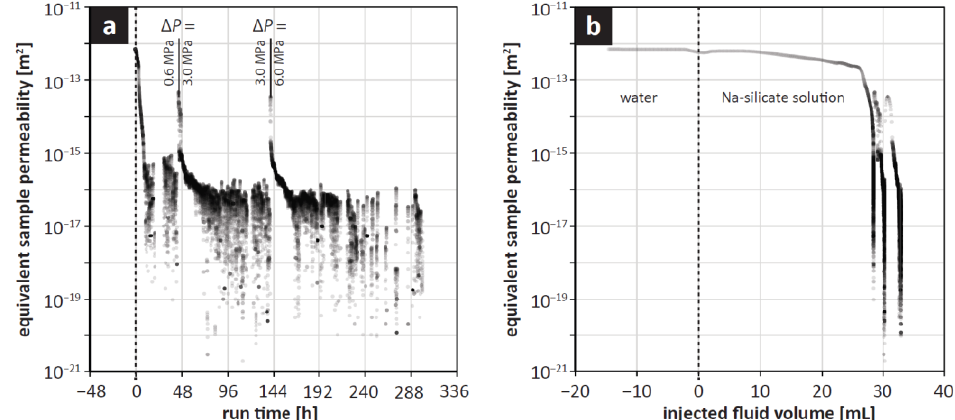
Figure 5. Reactive flow-through results for sample SIL-1. Equivalent Darcy permeability versus ( a ) elapsed time and ( b ) injected fluid volume. Run time and volume are shifted such that they equal zero at the moment when injection of sodium silicate solution was initiated (water-based reference results are thus plotted on the negative domains of the x-axes).